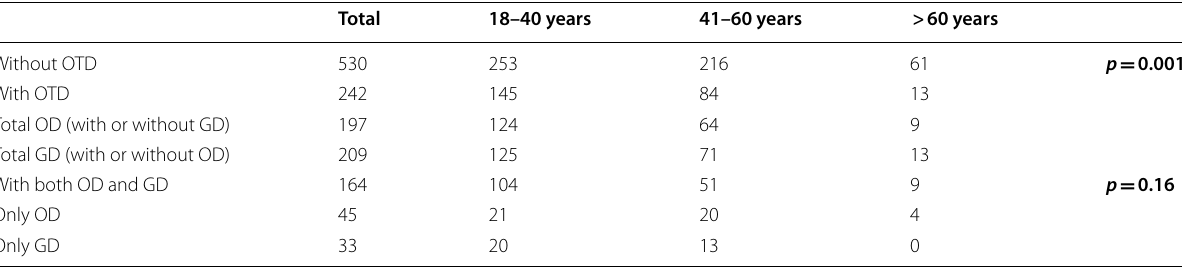
Table 3 Age-wise distribution of olfactory and gustatory